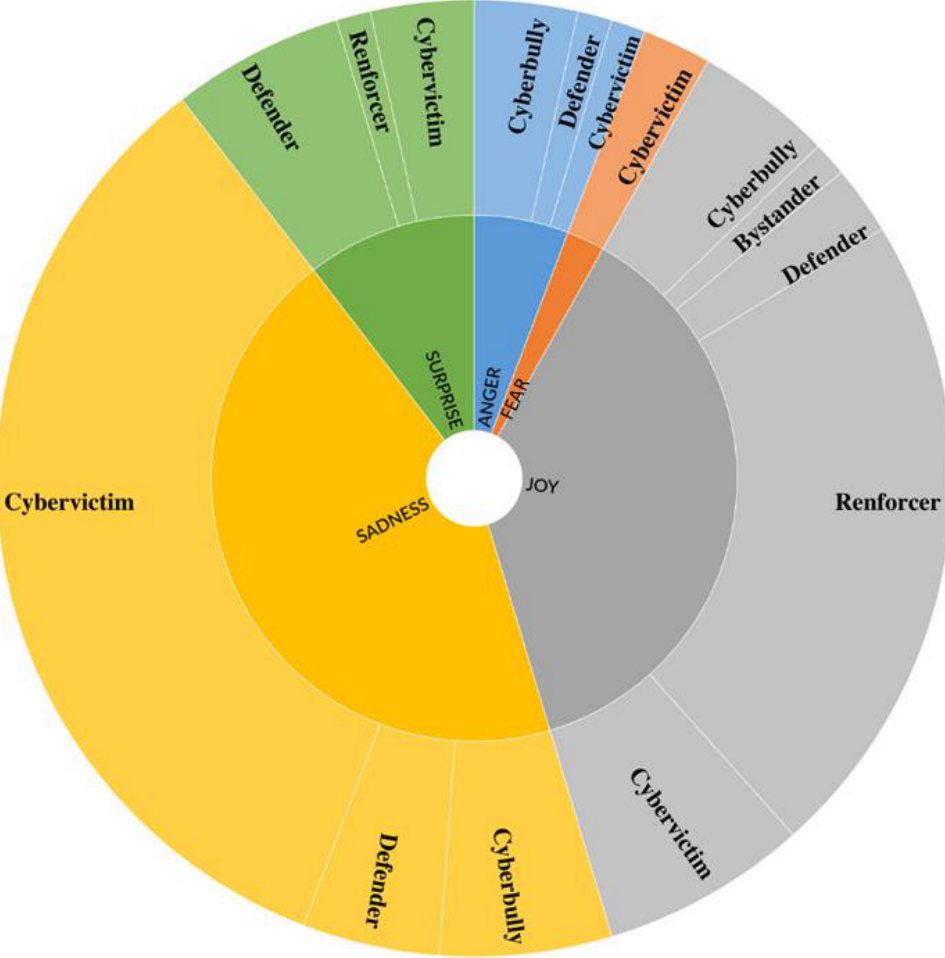
Figure 1. Emotions by role. The innermost circle represents the emotions; the external circle the roles for each emotion.